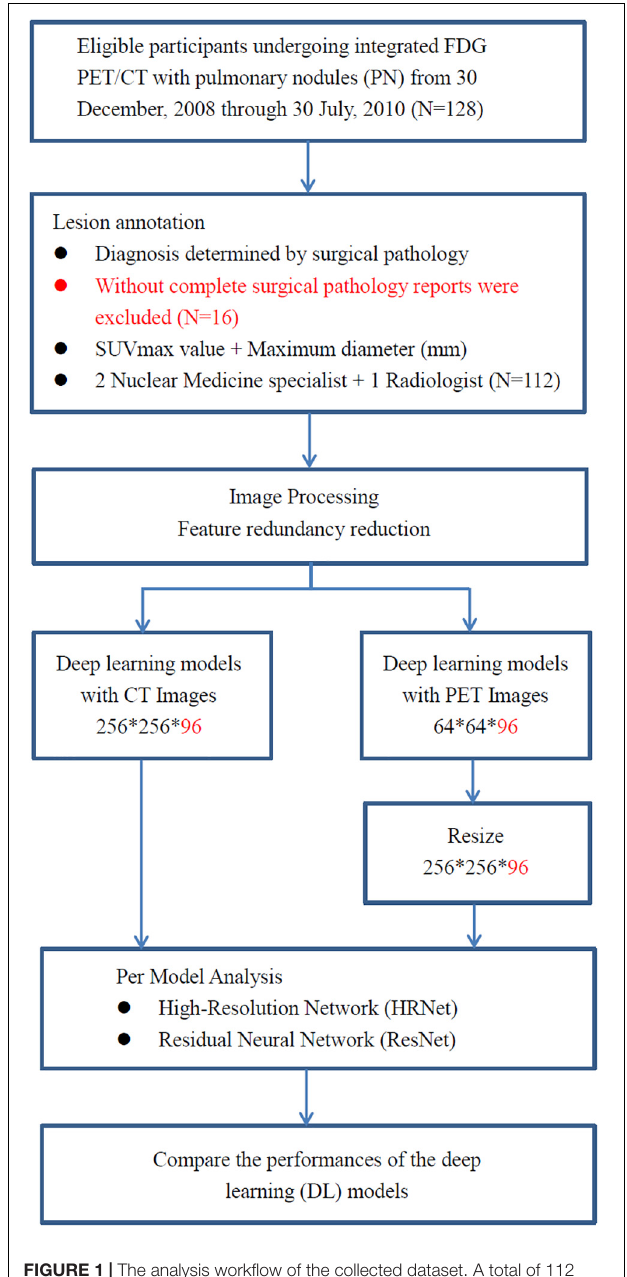
FIGURE 1 | The analysis workflow of the collected dataset. A total of 112 consecutive cases of eligible patients with pulmonary nodules (PN) were enrolled in this retrospective study from 30 December 2008 through 30 July 2010 at China Medical University Hospital. Patients with pulmonary nodules had definitive diagnosis determined by surgical pathology. All of them underwent integrated FDG PET-CT prior to surgical resection of pulmonary